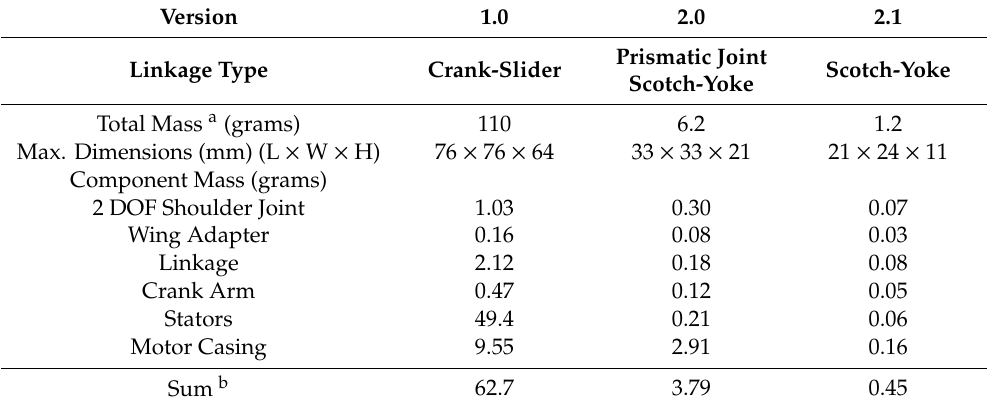
Table 2. Specifications of each flapping-wing